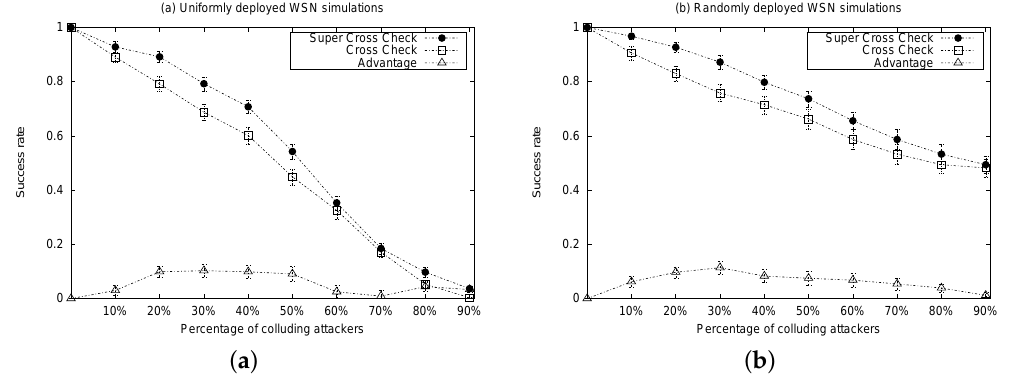
Figure 5. Comparative representation of the successful detection rate with regard to the super cross-check (SCC) algorithm and the cross-check (CC) algorithm. Advantage represents the difference between the success rate of the SCC and CC algorithm results. ( a ) Uniform deployment; ( b ) Random deployment. WSN: wireless sensor network.